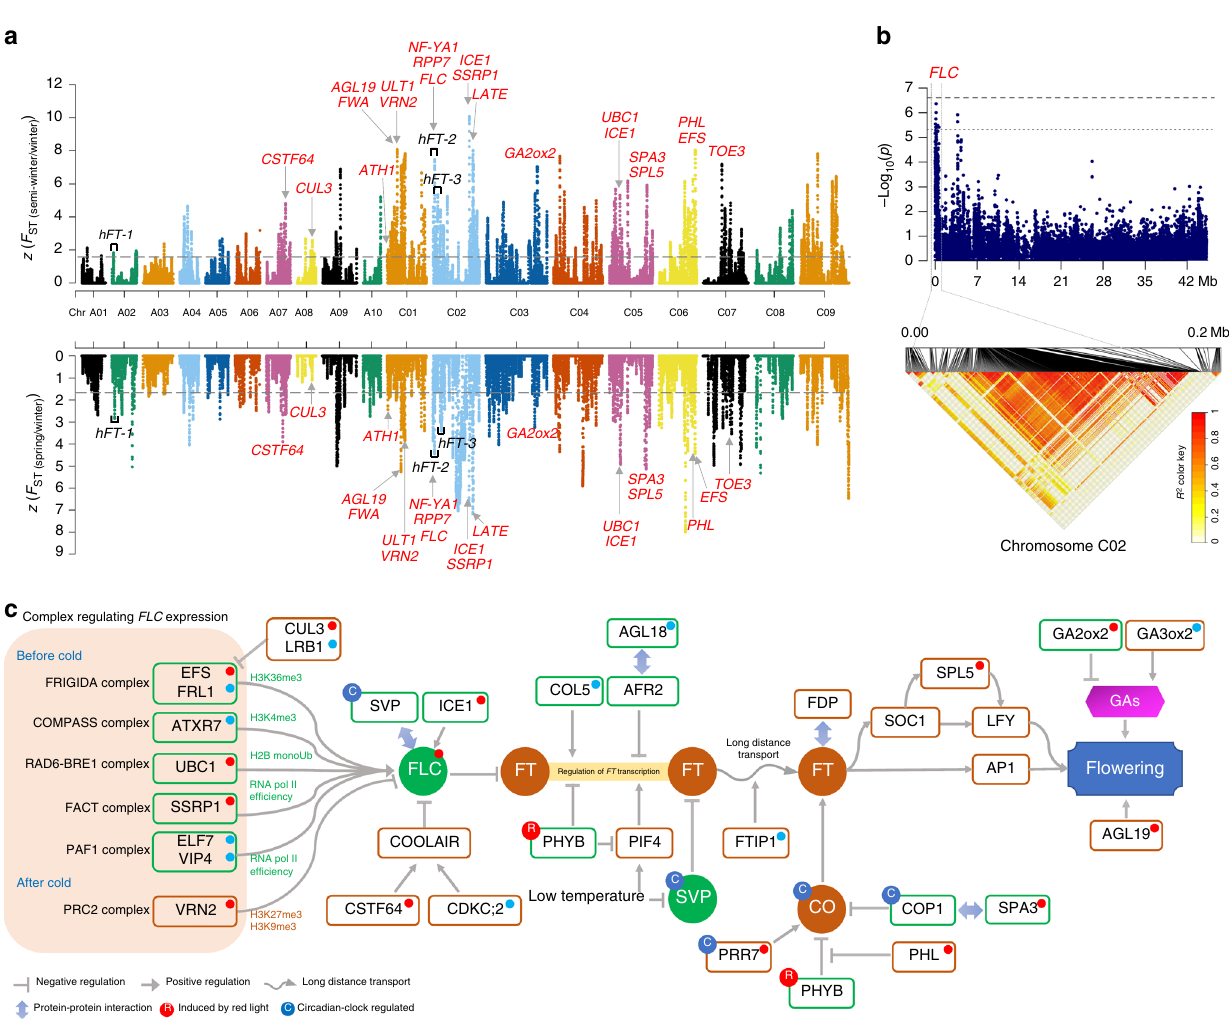
Fig. 5 Overview of fl owering-time regulation under the selection of the ecotype improvement of B. napus . a Genome-wide screening of ecotype improvement selection signals of F ST (semi-winter/winter) and F ST (spring/winter) . Flowering-time genes simultaneously identi fi ed in selection outlier regions between winter and spring ecotypes, and between winter and semi-winter ecotypes are labeled in red in the corresponding chromosomes. Full descriptions of these genes are shown in Supplementary Data 36. Three LD blocks containing signi fi cant GWAS associations for fl owering time are labeled in black. b GWAS results of fl owering time that overlapped with selection signals. Dashed horizontal lines depict the signi fi cant ( − log10( P ) = 6.61) and suggestive ( − log10( P ) = 5.31) thresholds. Lower panel shows the LD blocks of signi fi cantly associated loci in GWAS. c Major fl owering-time pathways and selective effects acting on their components during ecotype improvement. Brown and green rounded rectangles represent proteins involved in positive and negative regulation of fl owering time, respectively. Flowering integrator proteins are shown in brown and green dots, respectively. Red dots at the top right of gene symbols represent fl owering-time-regulation genes simultaneously identi fi ed in the selection outlier regions both semi-winter/winter and spring/winter comparisons, and purple and blue dots represent those of spring/winter and semi-winter/winter comparisons, respectively. Source data are provided as